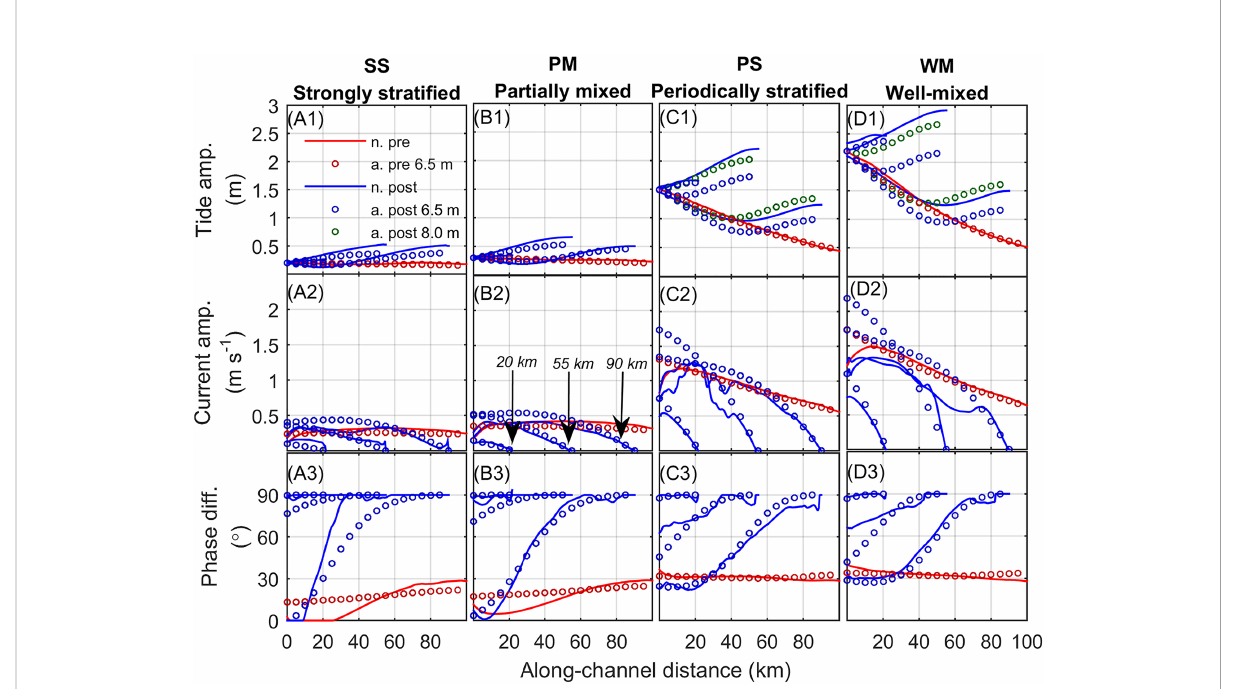
FIGURE 3 Pre- and post-dam along-channel pro fi les of (A1-D1) M 2 tidal amplitude (m), (A2-D2) M 2 current amplitude (m s -1 ), and (A3-D3) phase difference between current and tide (°) depending on estuarine dam location (dam at x = 20, 55, and 90 km). Along-channel is distance is from the estuary mouth, positive landward. n. is numerical, a. is analytical, pre is pre-dam, post is post-dam, and 6.5 m and 8.0 m represent the depth at the estuary mouth used in the analytical model. Most analytical models used 6.5 m. All results correspond to scenarios with discharge intervals D t = 3